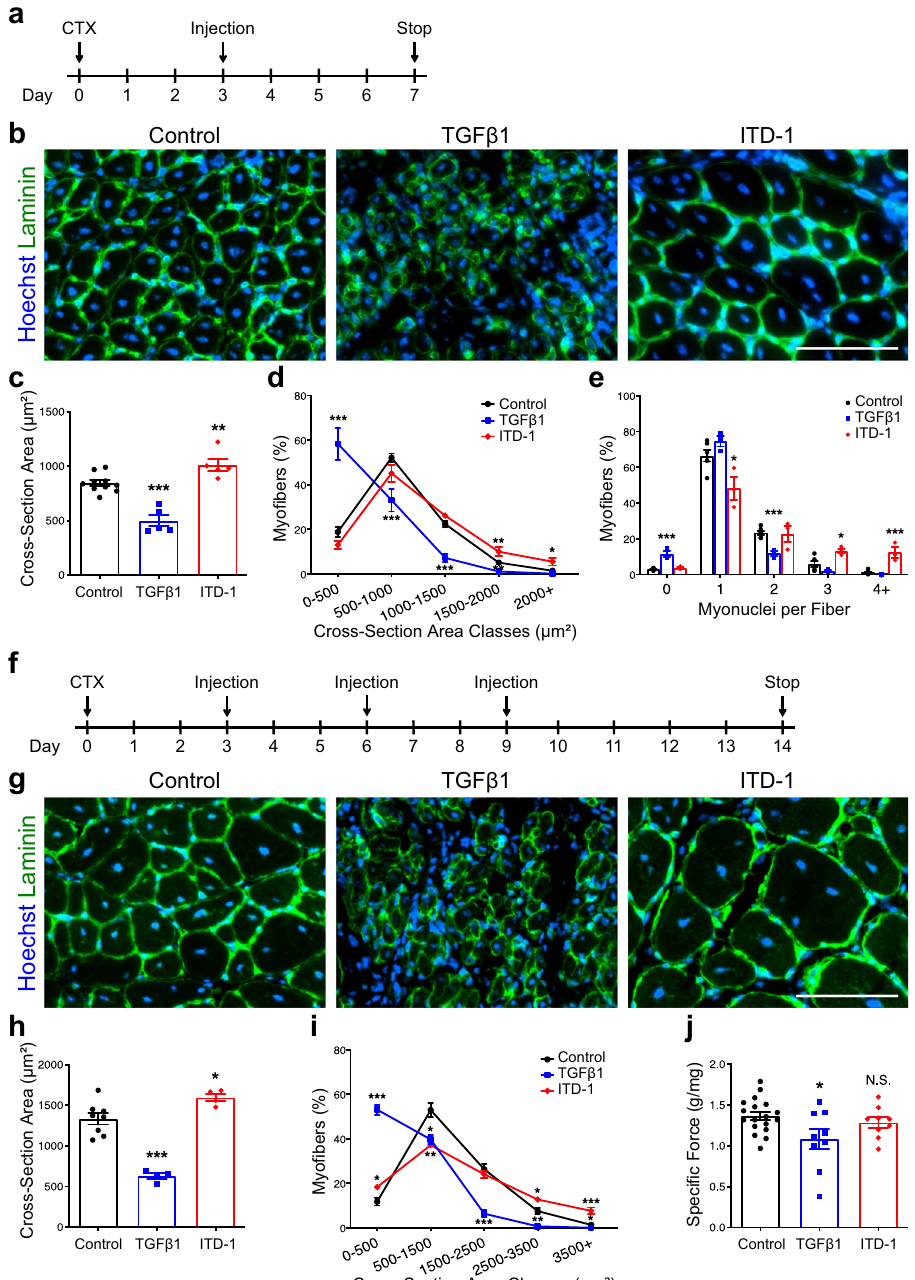
Fig. 8 TGF β signaling regulates muscle cell fusion in vivo. a Experimental scheme. Adult murine tibialis anterior (TA) muscles were subjected to CTX injury and regenerating tissues were injected intramuscularly with either TGF β 1 proteins or ITD-1 compound 3 days after damage. b Immuno fl uorescent staining for LAMININ of 7 days regenerating TA muscles. c Quanti fi cation of myo fi ber size (cross-sectional area, CSA). While the injection of TGF β strongly reduces fi bers size, ITD-1 administration increases fi bers size. d Distribution of myo fi ber CSA. N = 10 (Control), 5 (TGF β 1), and 5 (ITD-1) biologically independent TA muscles. e Distribution of myonuclei per fi ber shows that the inhibition of TGF β cascade leads to the formation of multinucleated myo fi bers, while TGF β activation reduces the number of myonuclei per fi bers. N = 6 (Control), 3 (TGF β 1), and 3 (ITD-1) biologically independent TA muscles. f Experimental scheme. Adult murine TA muscles were subjected to CTX injury and regenerating tissues were injected with either TGF β proteins or ITD-1 compound 3, 6, and 9 days after damage. Fourteen days after injury, force measurements were performed, and TA muscles were collected. g Immuno fl uorescent staining for LAMININ of 14-day regenerating TA muscles. h Quanti fi cation of myo fi ber size con fi rms the phenotypes observed at 7 d.p.i. N = 8 (Control), 4 (TGF β 1), and 4 (ITD-1) biologically independent TA muscles. i Distribution of myo fi ber CSA. N = 8 (Control), 4 (TGF β 1), and 4 (ITD-1) biologically independent TA muscles. j Speci fi c force measurement of regenerating muscles. While TGF β 1-treated muscles are weaker compared to the control, ITD-1-injected muscles show no differences. N = 18 (Control), 9 (TGF β 1), and 9 (ITD-1) biologically independent TA muscles. Scale bars: b , g , 100 μ m. Data are presented as mean ± SEM. Unpaired two-tailed Student ’ s t tests were used to compare between data. *, **, and *** denote a signi fi cant difference with control group of P < 0.05, P < 0.01, and P < 0.001, respectively. Control represents mock-treated contralateral TA muscle. Source data are provided as a Source Data fi